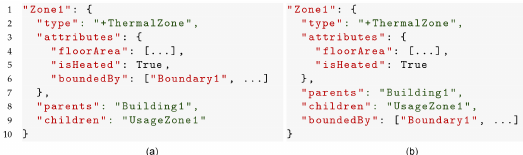
Figure 10. Storage of the “boundedBy” relation (a) as an additional attribute, and (b) an additional